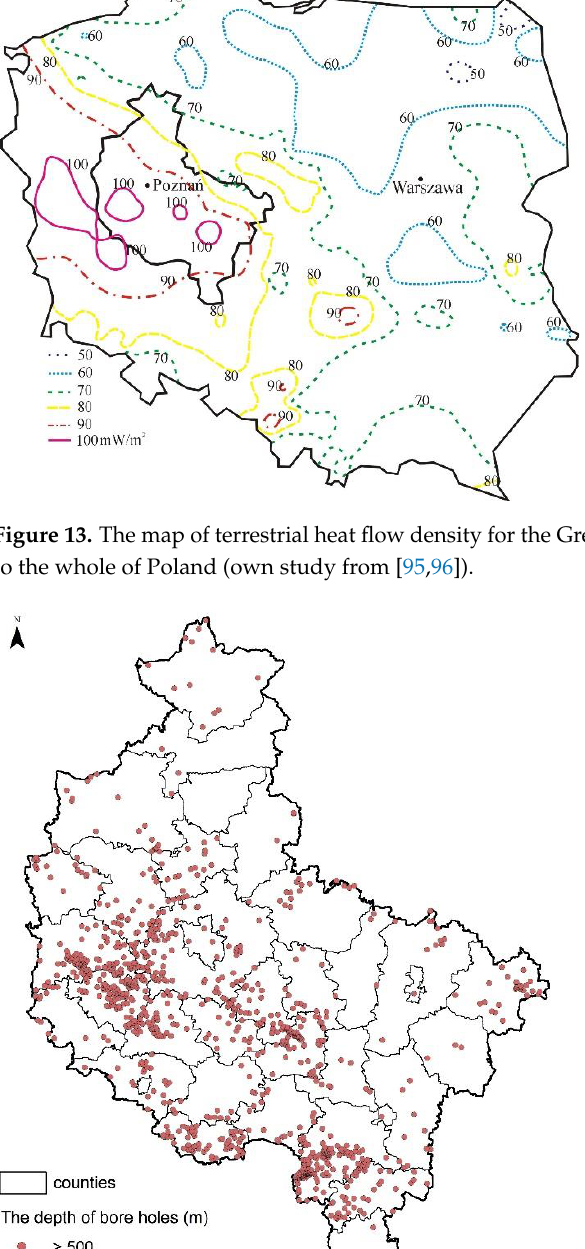
Figure 12. Location of sewage treatment plants with a minimum capacity of 1 million m 3 per year (own calculations).